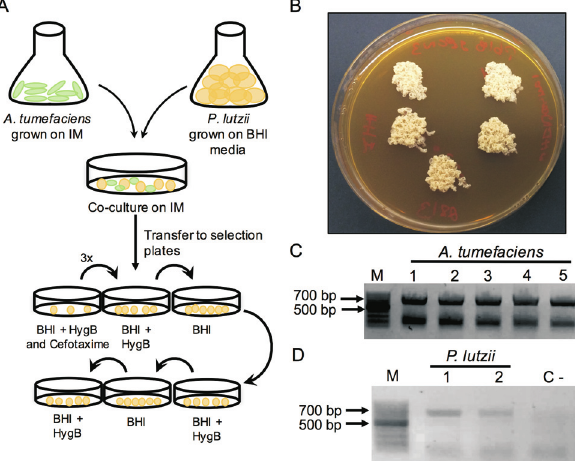
Figure 2 - Validation of pLUO vector in P. lutzii . ( A) Representative im- age of experiment workflow. The first selection plate contains Cefotaxime 100 (cid:2) g/mL to kill the remaining A. tumefaciens colonies. Afterwards, fun- gal colonies are selected on BHI containing only Hygromicin B for three rounds, and then alternating media with or without Hygromicyn until reachingnineroundsofmitoticstability.(B) P.lutzii coloniestransformed with pLUO vector after reaching mitotic stability. (C) Eletrophoresis gel showing the colony PCR reactions from A. tumefaciens as a positive con- trol with the hph gene amplified by its primers (resulting in a band of 705 base pairs; the lower band is an unespecific one that always appears for A. tumefaciens ). (D) Eletrophoresis gel showing the PCR reactions of P. lutzii transformants. M, molecular ladder; and C, negative control of the